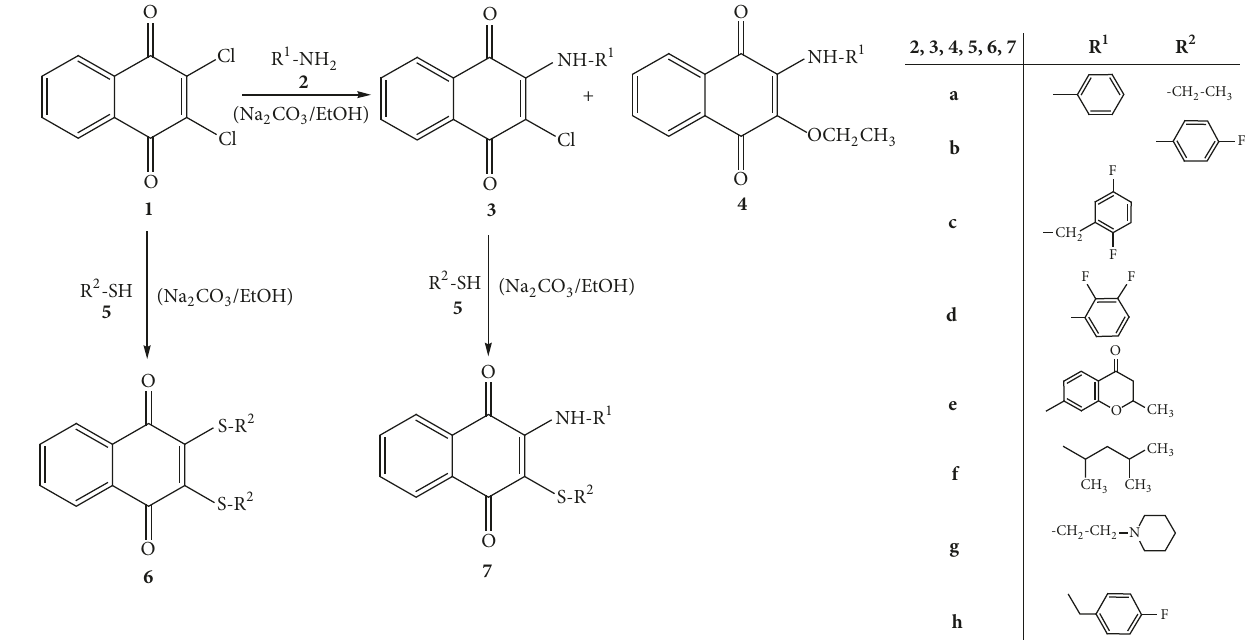
Scheme 1: The synthesis of N-, S-, O-substituted naphthoquinone derivatives ( 3a, 3c-d , 3f-g , 4e , 6b , 7a